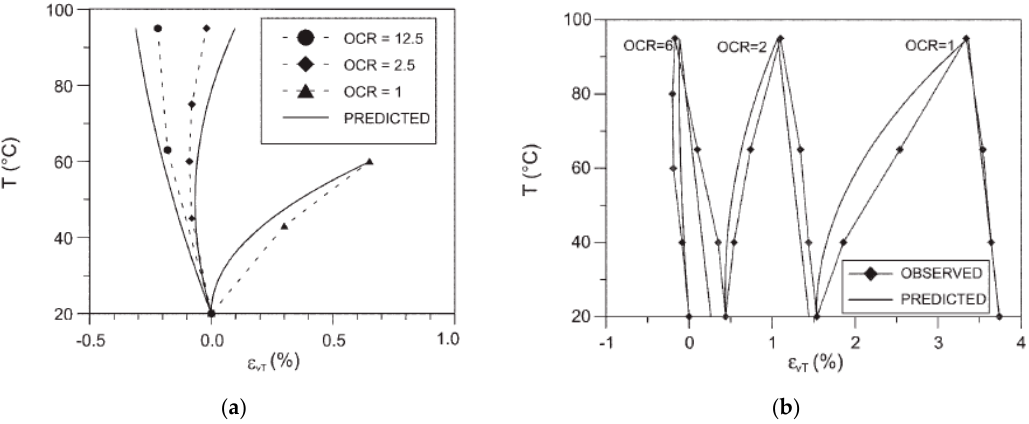
Figure 7. Comparison between predicted and observed results: ( a ) on Pontida silty clay [176], ( b ) on Boom clay [177].